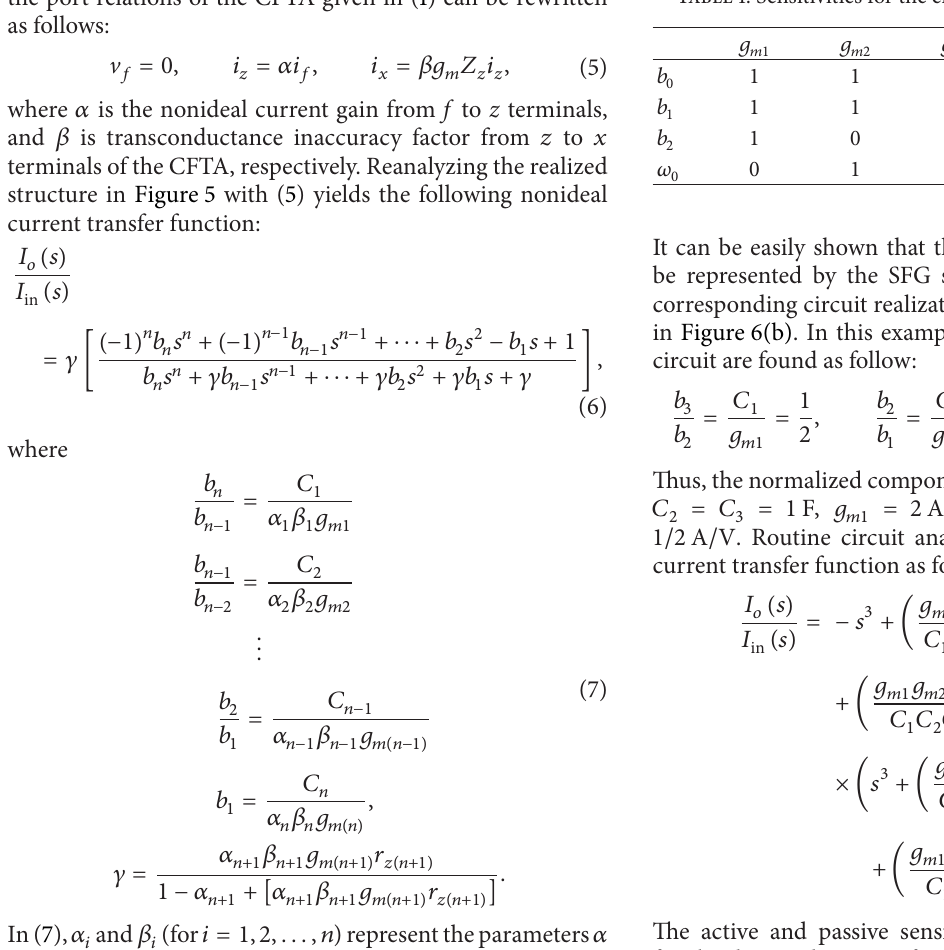
Table 1: Sensitivities for the circuit parameters in Figure